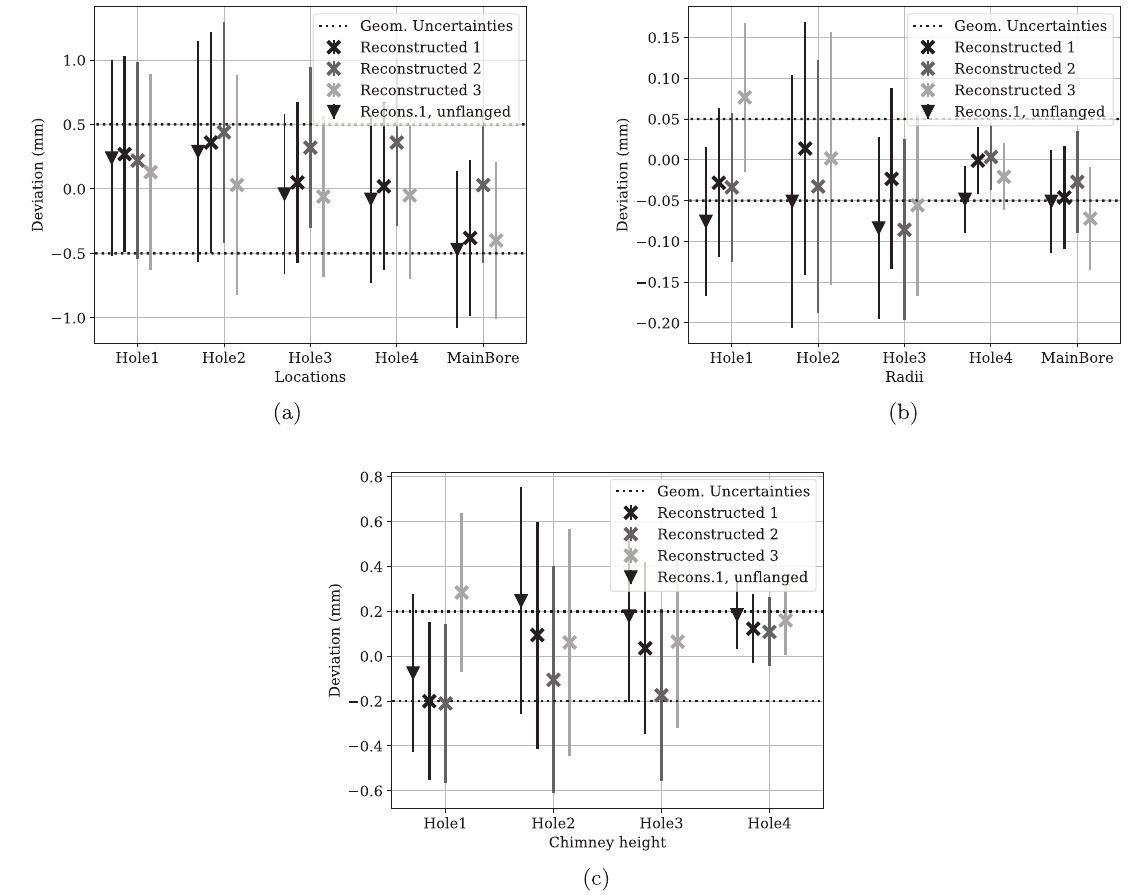
Figure 10. Deviation between manually measured and reconstructed geometries from the three sets of data. The crosses represent the results for the mixed radiation condition (holes fl anged, main bore un fl anged) and the triangle the results with only un fl anged radiation for the fi rst set of data. The direct measurement uncertainties (see Tab. 1) are indicated as dotted lines. (a) Hole locations and main bore length. (b) Hole radii and main bore radius. (c) Chimney